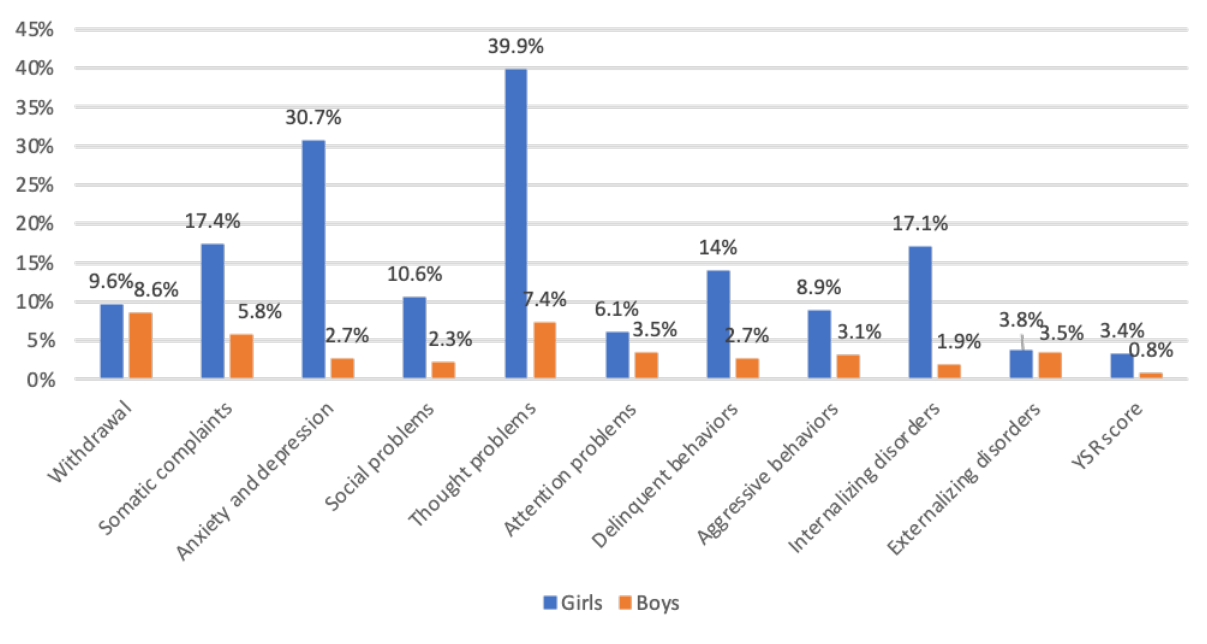
Figure 1. Proportions of clinical range scores on individual problem behavior scales in boys and